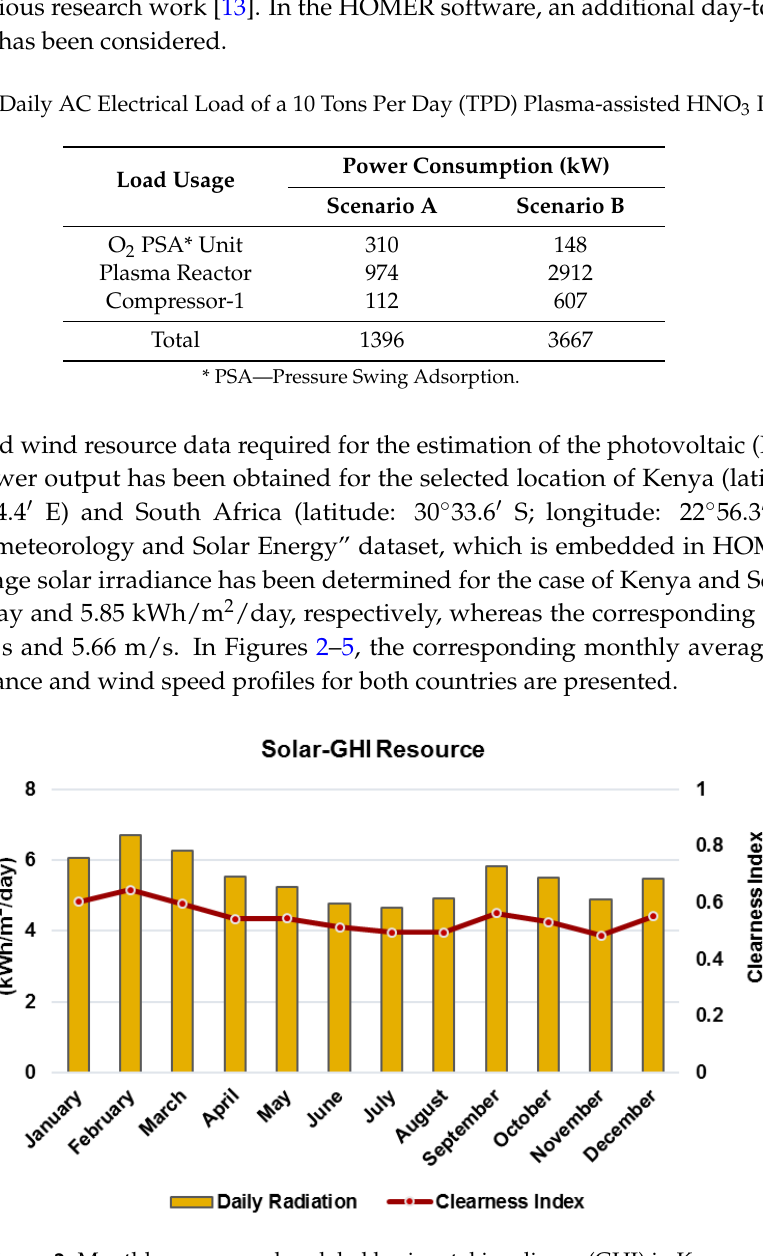
Figure 2. Monthly average solar global horizontal irradiance (GHI) in Kenya.